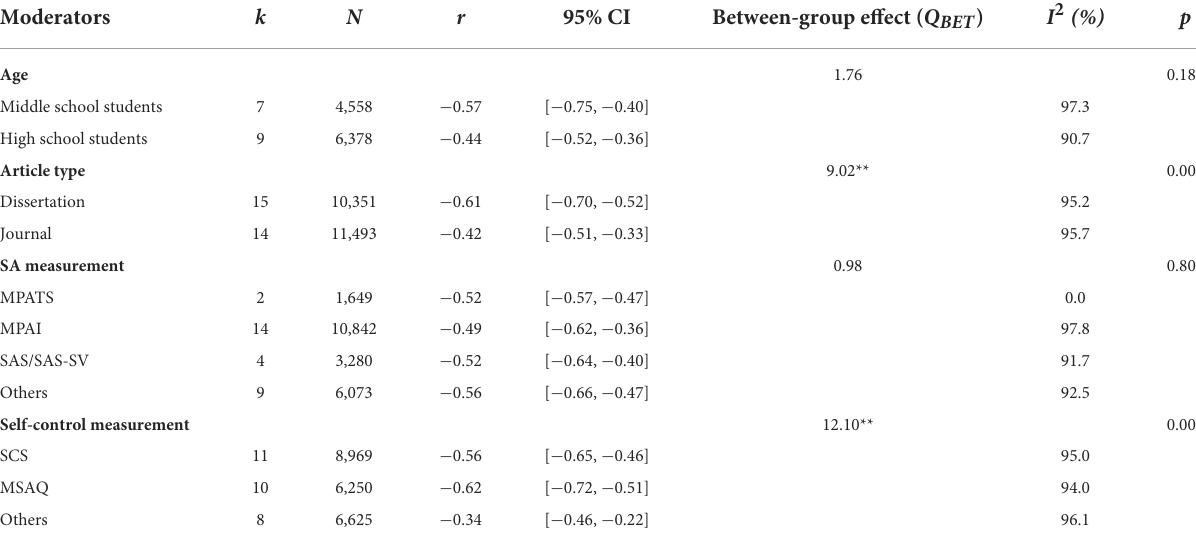
TABLE 5 Subgroup analyses of the summary correlation between smartphone addiction and self-control.